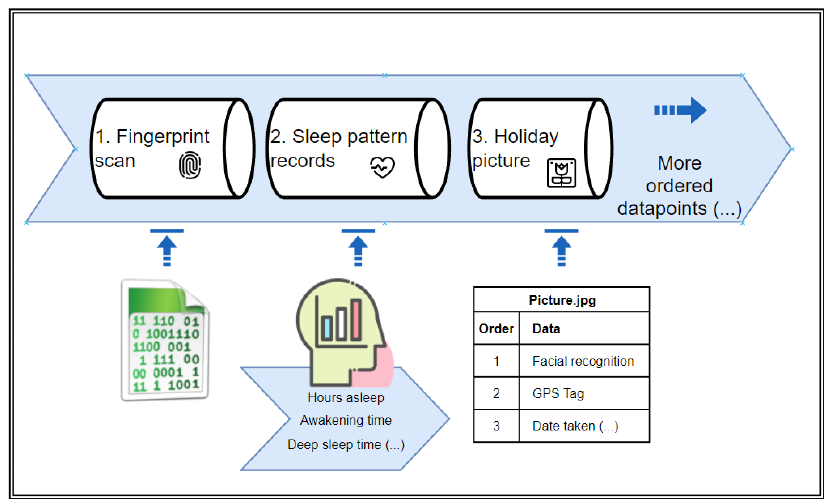
Figure 1. An example of the data vector order .